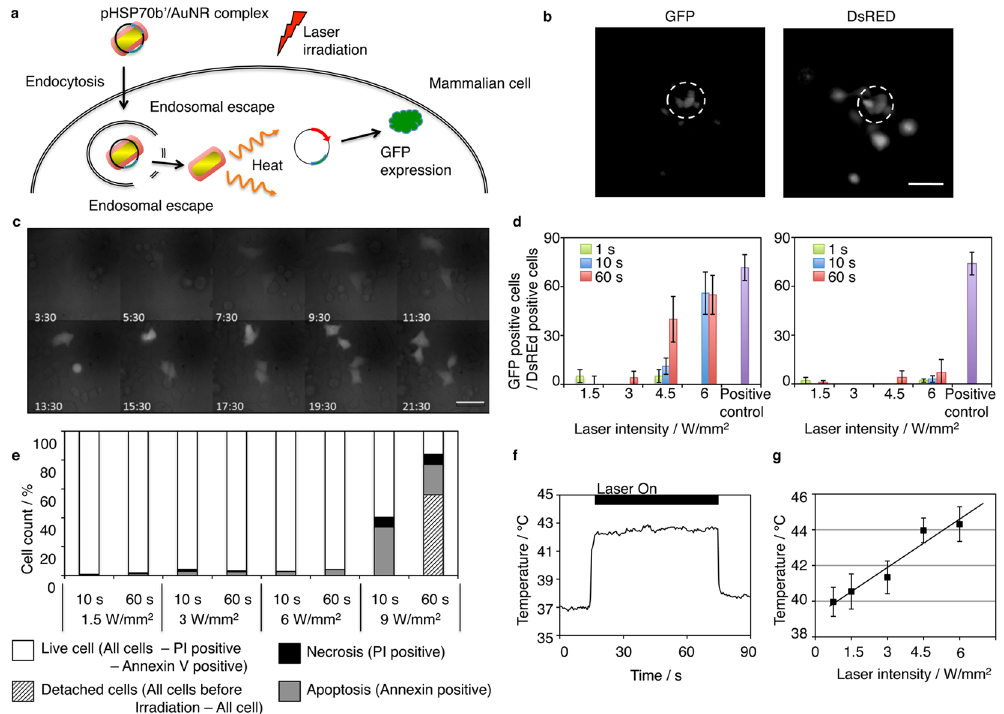
Figure 3. Intracellular photothermal heating of HEK293T cells by DOTAP-AuNRs. ( a ) Schematic of photothermal induction of protein expression by AuNRs. HSP70b ’ promoter-driven expression vector (pHSP70b’) is transfected into cells by DOTAP-AuNRs and activated by brief NIR illumination. ( b , c ) Photoinduced EGFP expression in HEK293T cells. pHSP70-GFP and pCMV-DsRed were cotransfected by DOTAP-AuNRs. After 24 h, DsRed-positive cells were illuminated at 780 nm (6 W/mm 2 , 10 s). White broken circles indicate the illuminated area. Representative fluorescence images 24 h after illumination are shown in ( b ) and time lapse images after illumination are shown in ( c ). Scale bars = 100 µ m in ( b ), 40 µ m in ( c ). ( d ) Photoinduction efficiency for DOTAP-AuNRs (left) and LF2000 (right). Data were calculated based on the number of EGFP-positive cells/the number of DsRed positive ( = photoinducible) cells within illuminated areas (n = 3, average ± SD). Data for the positive control were from cells incubated at 42 °C for 30 min (whole-cell heating). ( e ) Phototoxicity by intracellular photothermal heating. After illumination, cells were stained with Annexin-V and propidium iodine to detect apoptosis and necrosis, respectively. ( f ) Intracellular photothermal heating of AuNRs (780 nm, 6 W/mm 2 ). The temperature around intracellular DOTAP-AuNRs was estimated utilizing the temperature dependence of Rho-PE fluorescence intensity (Fig. S9). Within a few seconds of illumination, the temperature reaches approximate 42 °C, which is the threshold temperature (42 °C) of HSP70b ’ promoter activation. ( g ) Laser power intensity-dependence of the maximum temperature around illuminated AuNRs (n = 3, average ±